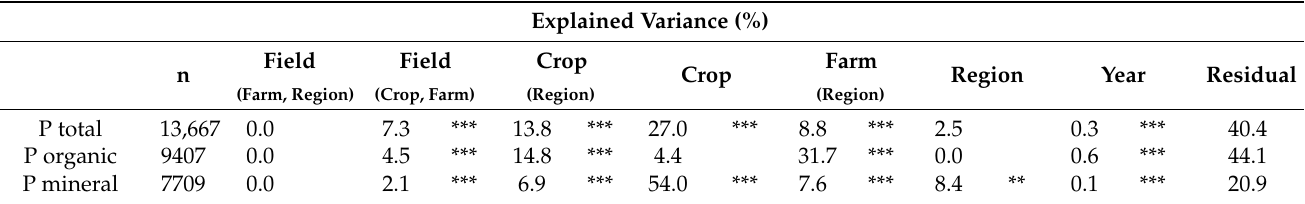
Table 4. Explained variance (%) of the explanatory variables (field, farm, year, crop and region) for the P amount used. Totals above 100 are due to rounding errors. n: fields considered for analysis. Significance codes: ** p < 0.01 and *** p <